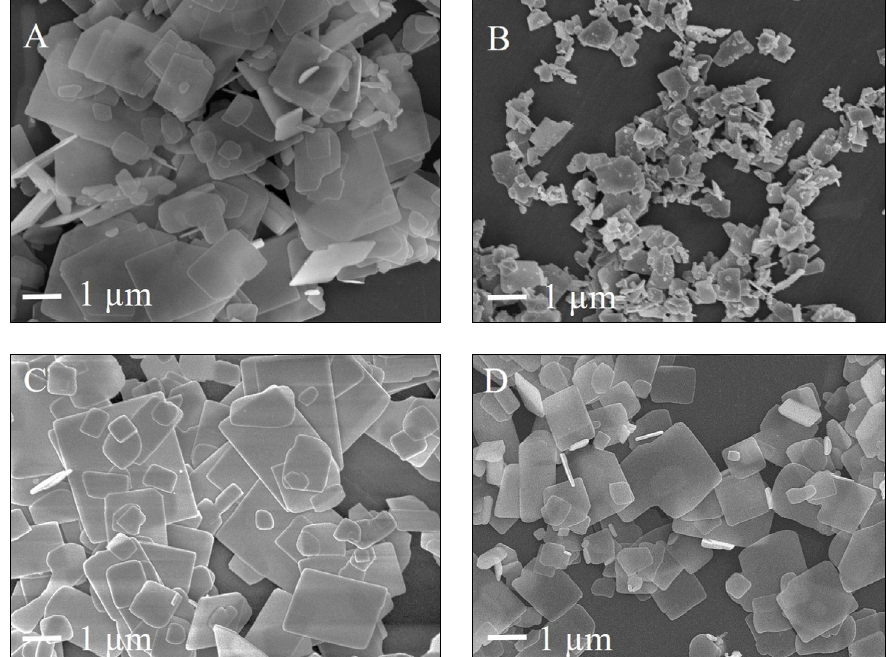
Figure 1 : SEM micrographs of the Bi 4 Ti 3 O 12 plates that were synthesized at 800 °C for 20 min (B-BIT2) and for 2h (A-BIT1, C-BIT5, D-BIT8). Other synthesis details are shown in Table 1.